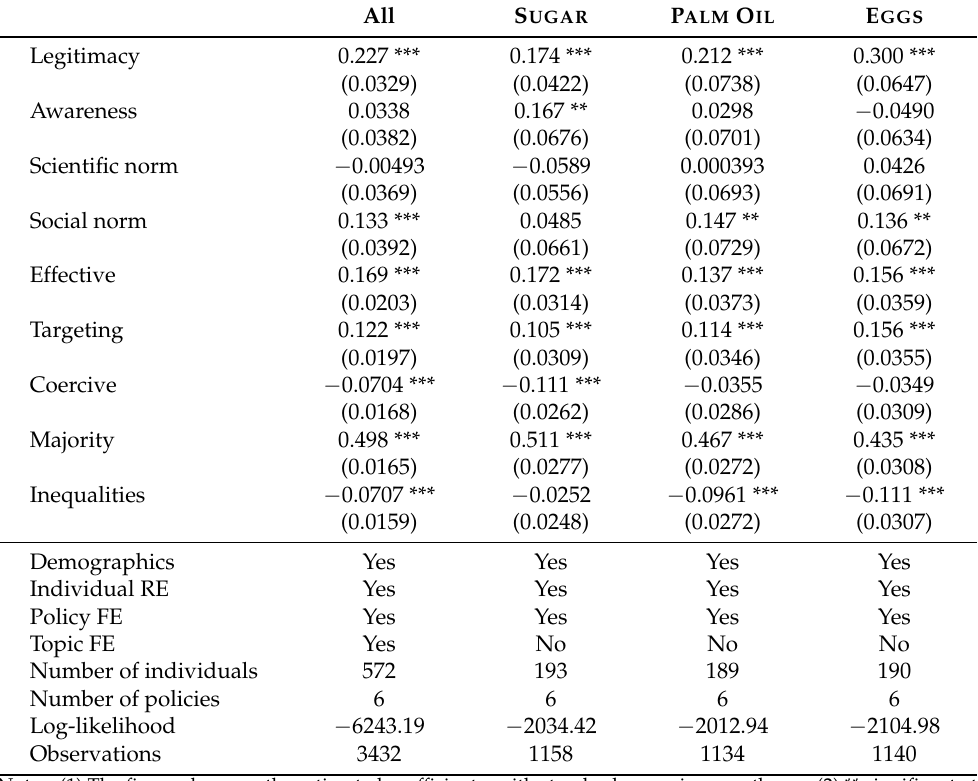
Table 6. Regression of policy acceptability